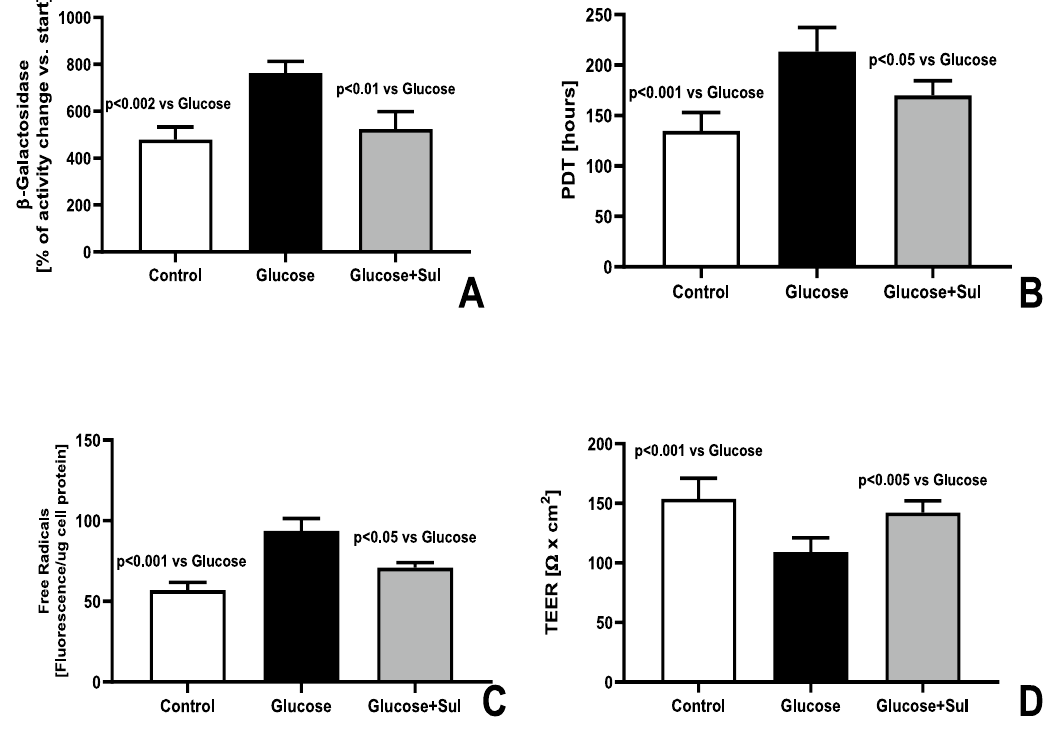
Figure 2. Activity of β-galactosidase ( A ), population doubling time ( B ), intracellular oxidative stress ( C ) and TEER ( D ) in HREC at the end of the replicative senescence in control medium (Control), medium supplemented with glucose 20 mmol/L Glucose) or medium supplemented with glucose 20 mmol/L and Sulodexide 0.5 LRU/mL (Glucose + Sul) (n = 8) (ANOVA